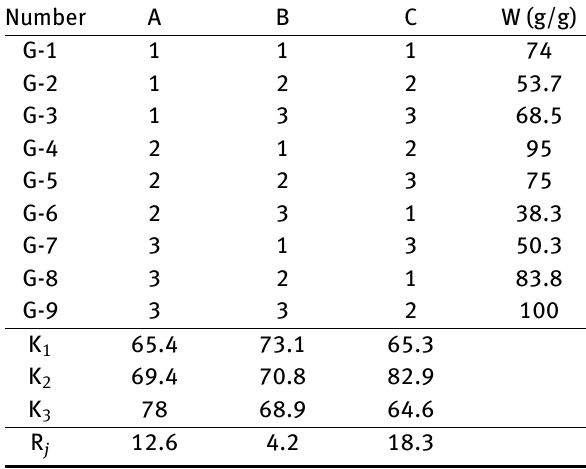
Table 2: Orthogonal experimental results and range analysis